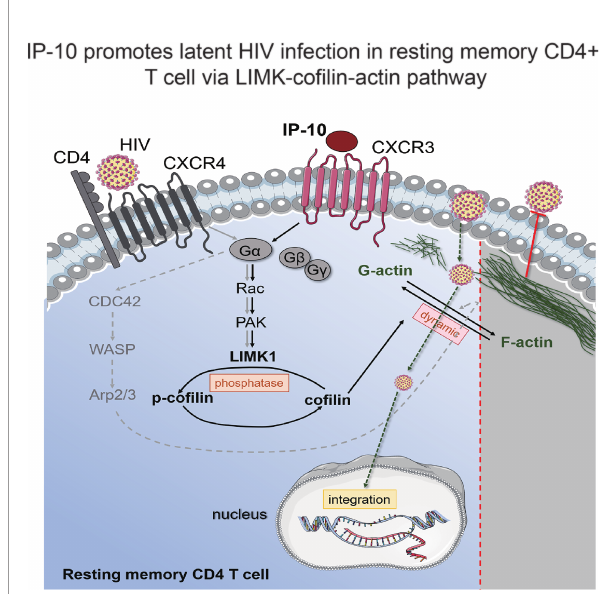
FIGURE 7 | Model of IP-10-induced enhancement of latent HIV infection and reservoir establishment in resting memory CD4 + T cells. A signaling pathway common to HIV (gray solid line) and IP-10 (black solid line) induces actin activation. IP-10 binds to CXCR3 expressed on the surface of resting memory CD4 + T cells; Rac stimulates p21-activated kinase (PAK), which activates LIMK, leading to co fi lin phosphorylation and actin polymerization. Another reported signaling pathway for latent HIV infection of resting CD4 + T cells (dotted line) involves HIV binding to CXCR4; the signal is transferred to CDC42, which activates Wiskott-Aldrich Syndrome family protein (WASP) and actin-nucleating protein (Arp2/3) to promote actin